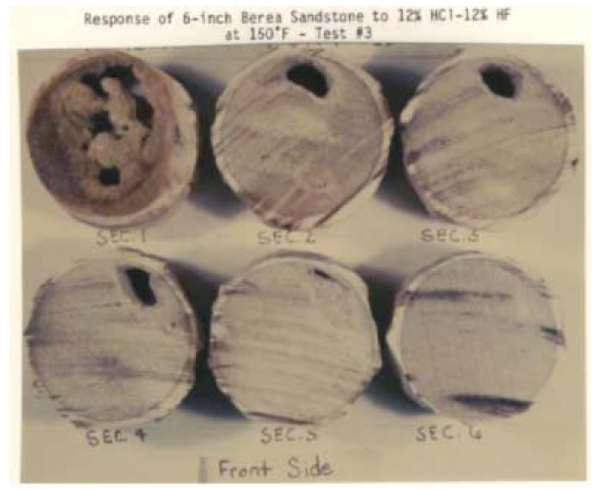
Fig. 5 Wormholes in Berea sandstone by Lamb (1998)